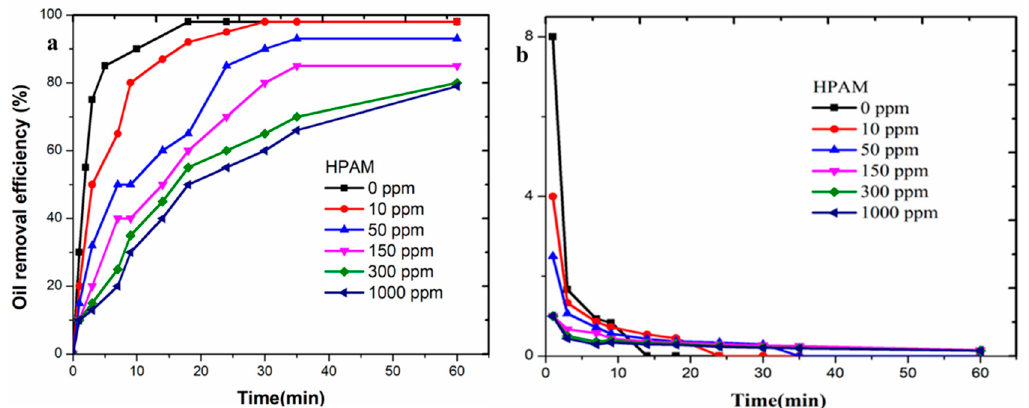
Figure 12. Super-hydrophobic mesh separation of the ( a ) oil removal efficiency and ( b ) filtration rate, operating condition O/W = 20/80, HPAM = 50 ppm, shear rate = 5000 rpm.